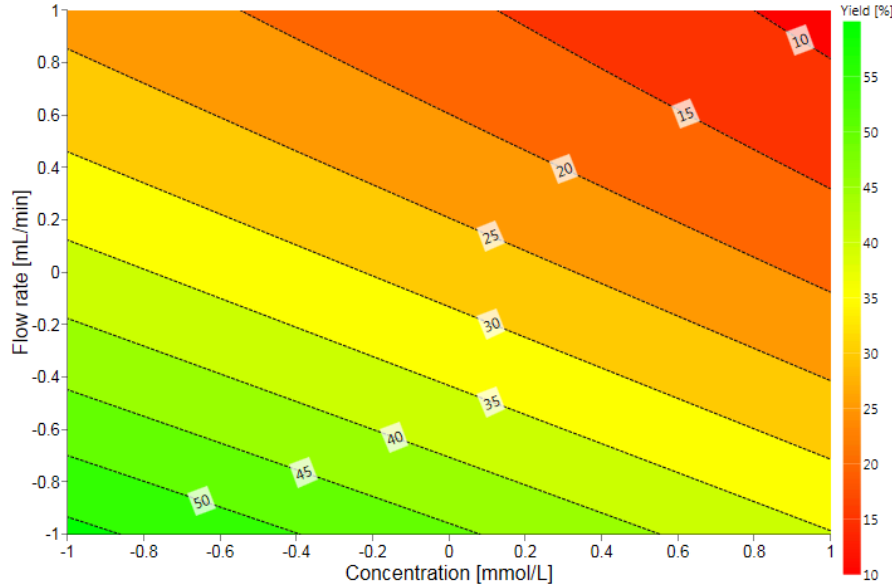
Figure 11. Contour plot for the performance of the continuous flow process for Ba 2+ cross-linked alginate. Stock: 250–750 mM of 2 , 500–1500 mM (2 mol-eq.) of 1 in 0.1 M of TEOA buffer, pH 7.5, with 1.4% of DMSO. T = 32.5 °C; flow rate: 0.1–0.5 mL/min; 350 mg of freeze-dried E. coli hosting DERA on 850 mg of luffa sponge (10 mL of 2% ( w / v ) Na-alginate solution); cross-linking by 2% ( w / v ) BaCl 2 solution.